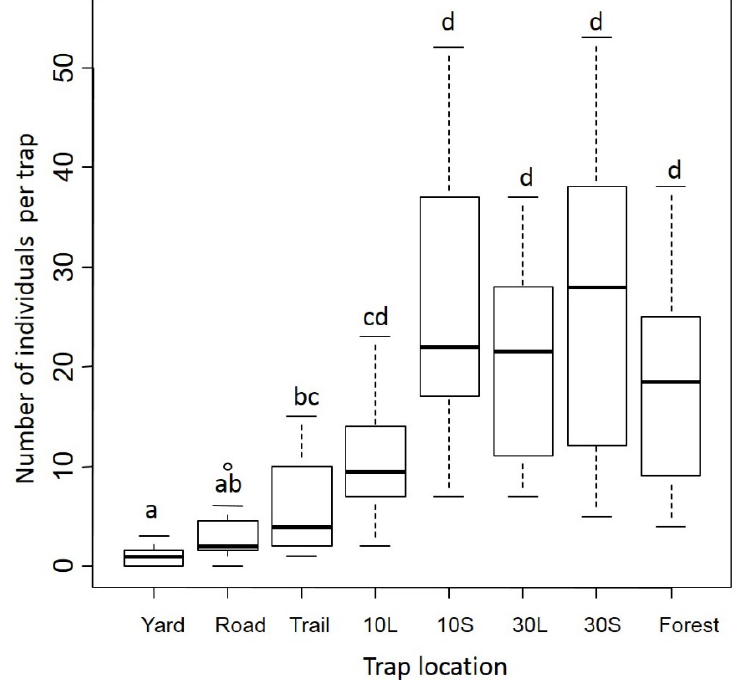
Figure 3. Number of dung beetle individuals (abundance) collected with baited pit-fall traps; Yard, log yards; Road, logging roads; Trail, skid trails; 10 L, 30 L, 10 S, 30 S and Forest represent forests at 10 m or 30 m from logging roads, forest at 10 m or 30 m from skid trails and forests at 60 m from logging roads or skid trails, respectively. Data are shown with a median value (thick black line), 25th and 75th percentiles (upper and lower boundary of box) and maximum and minimum values (whiskers). Boxes labeled with different letters differ significantly among sites ( p < 0.05, Pairwise Wilcoxon Test with Holm